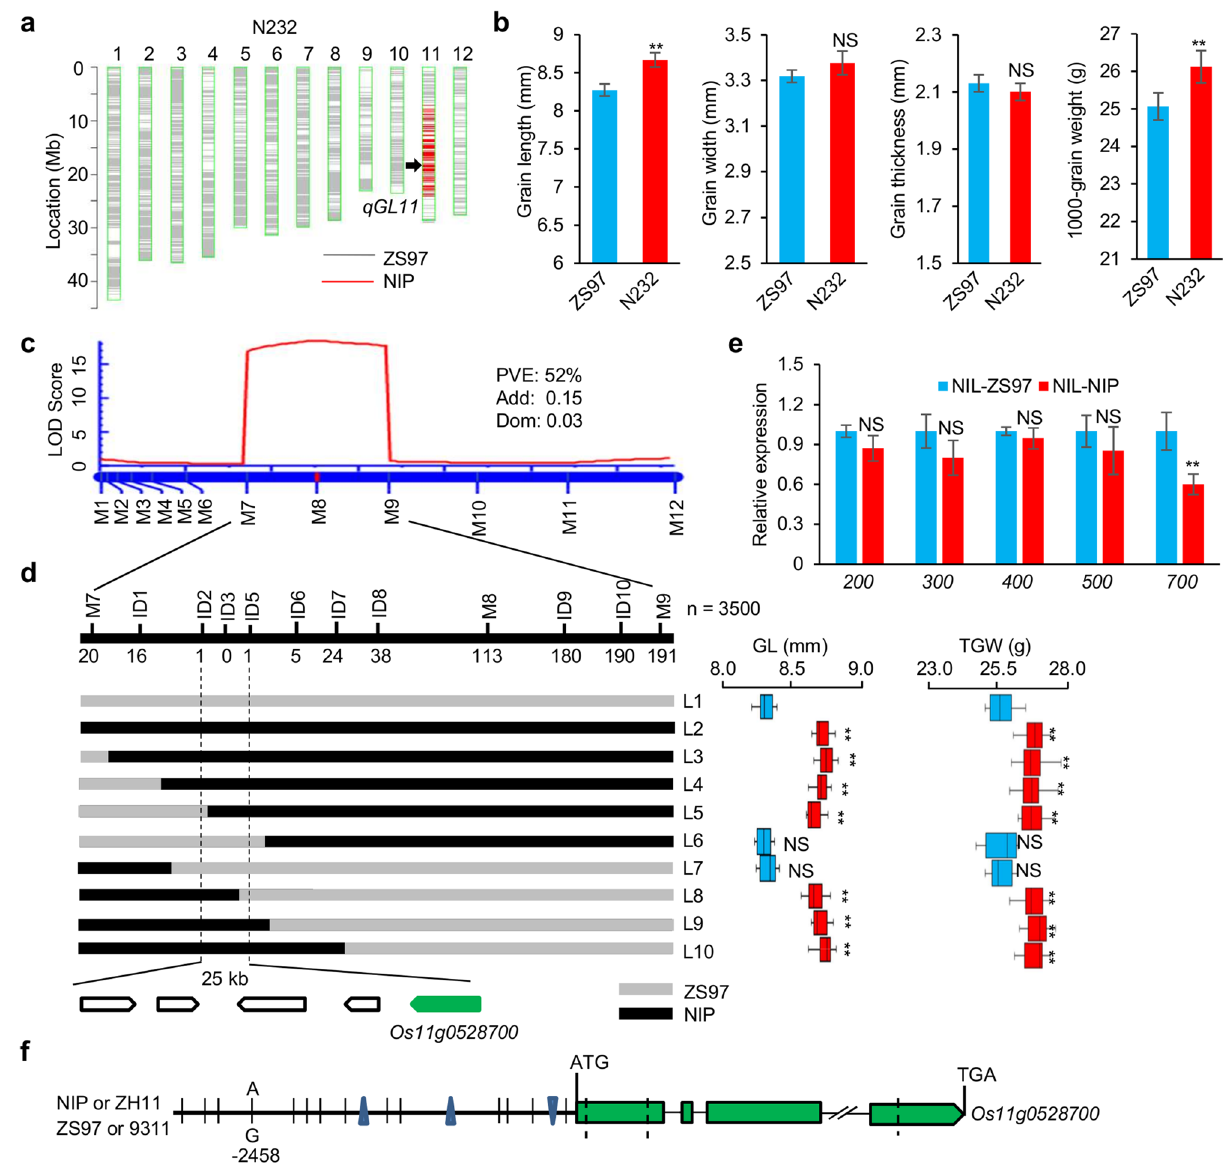
Figure 2. Fine mapping of qGL11 . ( a ) Graphic genotype of N232 showing a single substitution segment encompassing qGL11 . ( b ) Comparison of the grain size in ZS97 and N232. Differences between ZS97 and N232 in grain length, grain width, grain thickness and thousand-grain weight. Data are given as the mean and SE ( n = 6 individuals). ( c ) The QTL was detected in a CSSL-derived F 2 population. PVE, Add and Dom respectively represent phenotypic variation explained, additive effect and dominant effect. ( d ) Fine mapping of qGL11 in a 25-kb region using a large segregating population ( n = 3500). Five predicted genes are indicated, including Os11g0528700 (700) which was selected as the candidate gene. L3-L10 represent recombinant plants. Phenotype data for GL (grain length) and TGW (thousand-grain weight) are provided as the mean and SE ( n = 10). ( e ) Quantitative RT-PCR analysis of gene expression in the 8-cm panicle. Transcription levels relative to NIL-ZS97, which was set to 1, are presented as the mean and SE of triplicates. LOC_Os03g13170 ( Ubiquitin ) is the control gene. ( f ) Sequence comparison of Os11g0528700 among four cultivars. The triangle indicates a nucleotide deletion. **, * and NS indicate significant differences at P < 0.01, P < 0.05, and no significance, respectively, by Student’s t